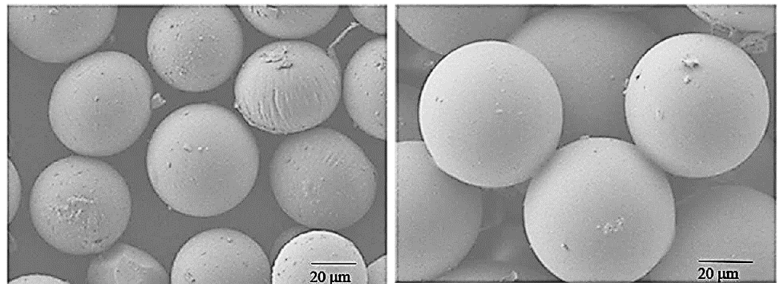
Figure 4. Scanning electron images of ketoprofen-microRNA-PLGA ( left ) and ketoprofen-PLGA ( right ) microparticles. Reprinted with permission from [56]. Copyright© 2018 Elsevier.